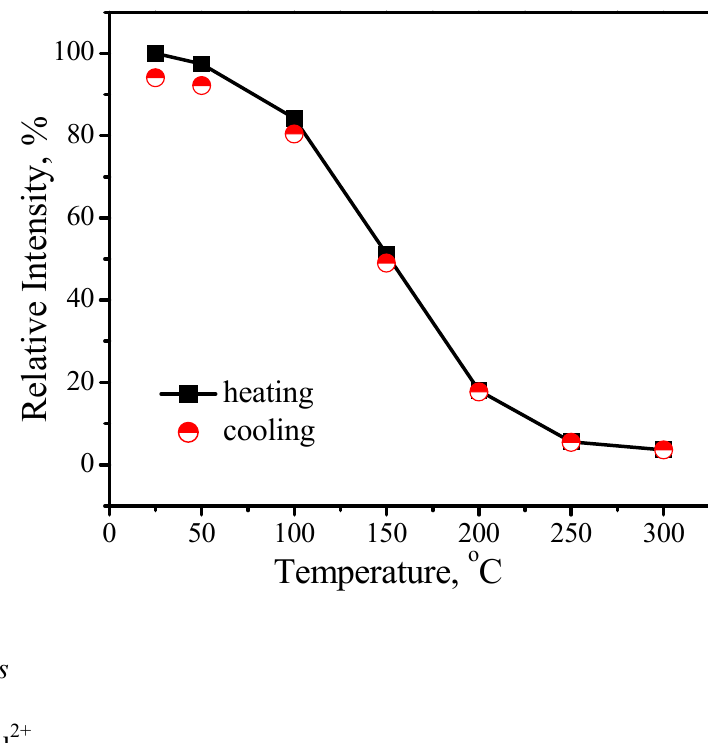
Ba Eu )SiO as a function of 1.7 0.2 0.1 4